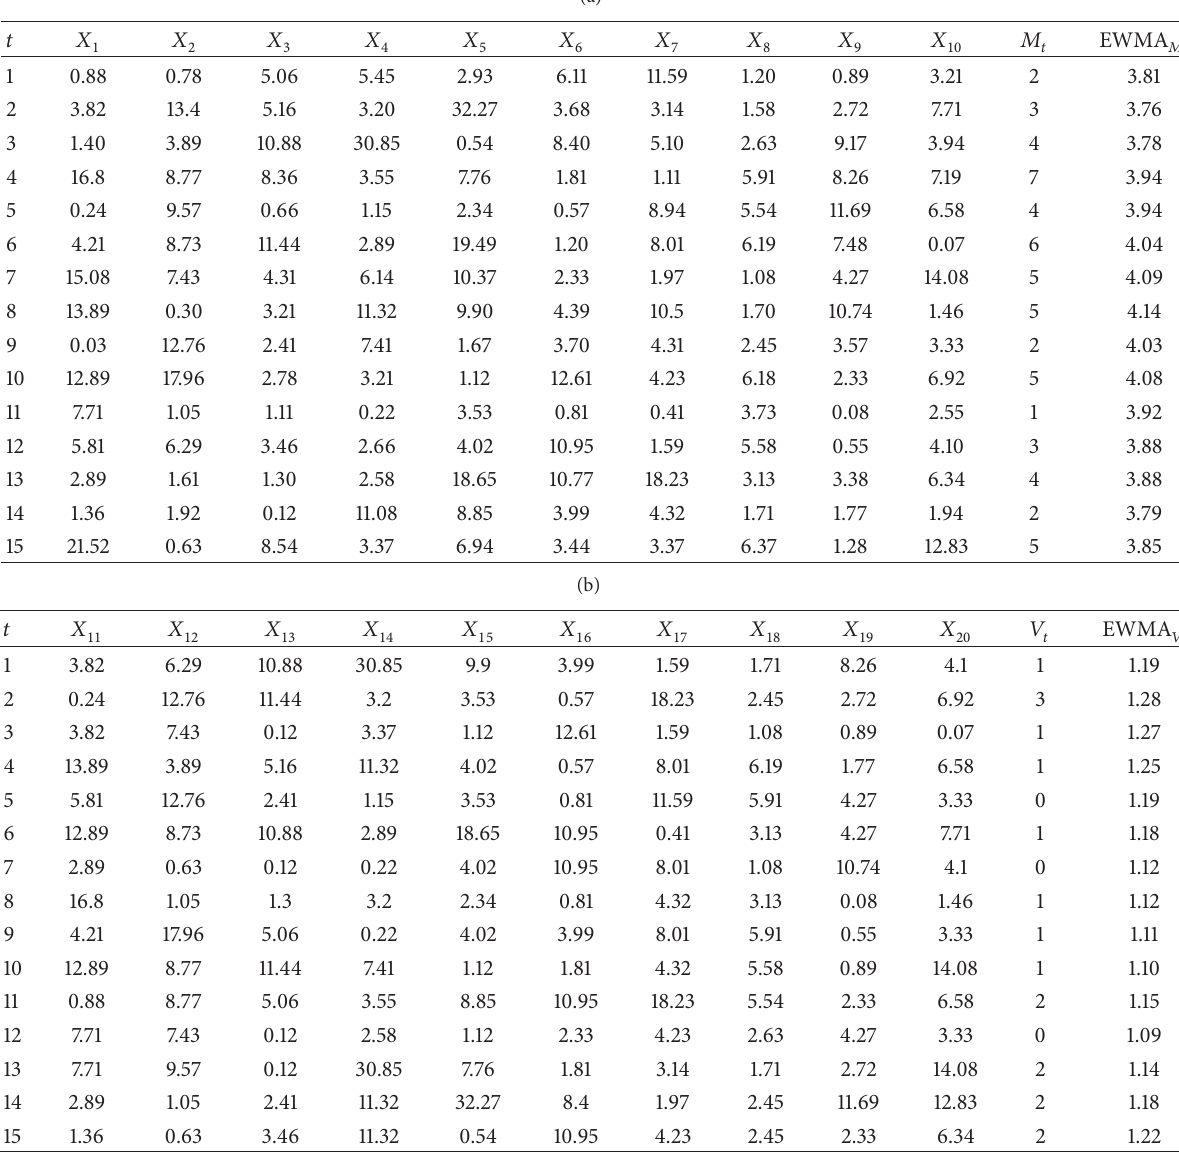
Table 12: (a) The service times from the first ten counters in a bank branch ( 𝜆 1 = 𝜆 2 = 0.05 ). (b) The service times from the last ten counters in a bank branch ( 𝜆 1 = 𝜆 2 = 0.05